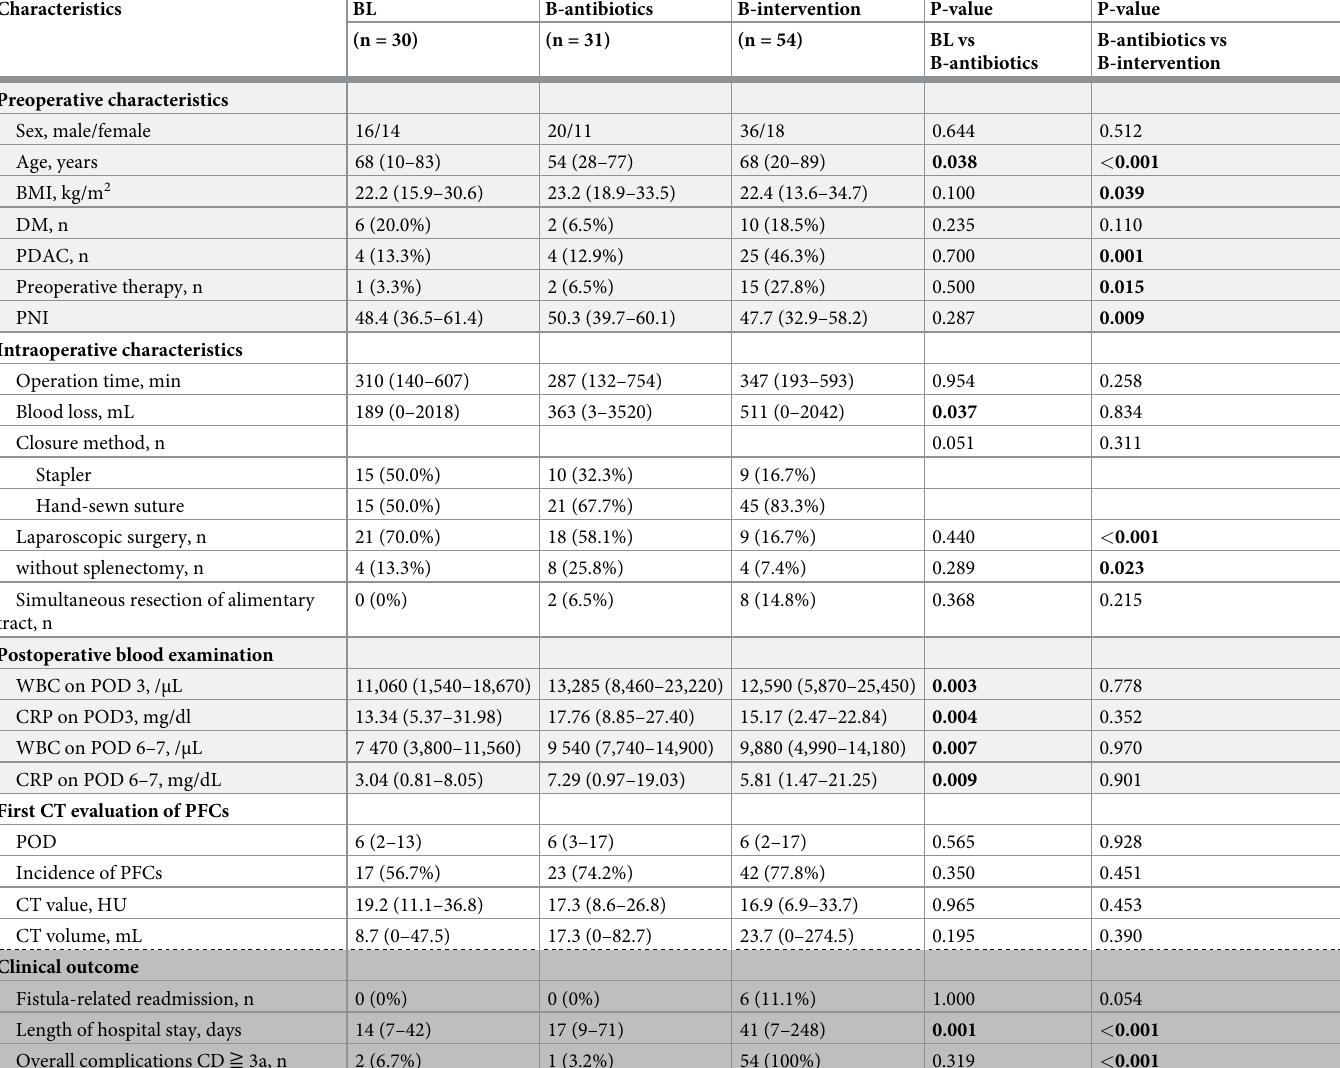
Table 3. Comparison of the perioperative characteristics and outcomes among patients with grade B postoperative pancreatic fistula and those with biochemical leak.